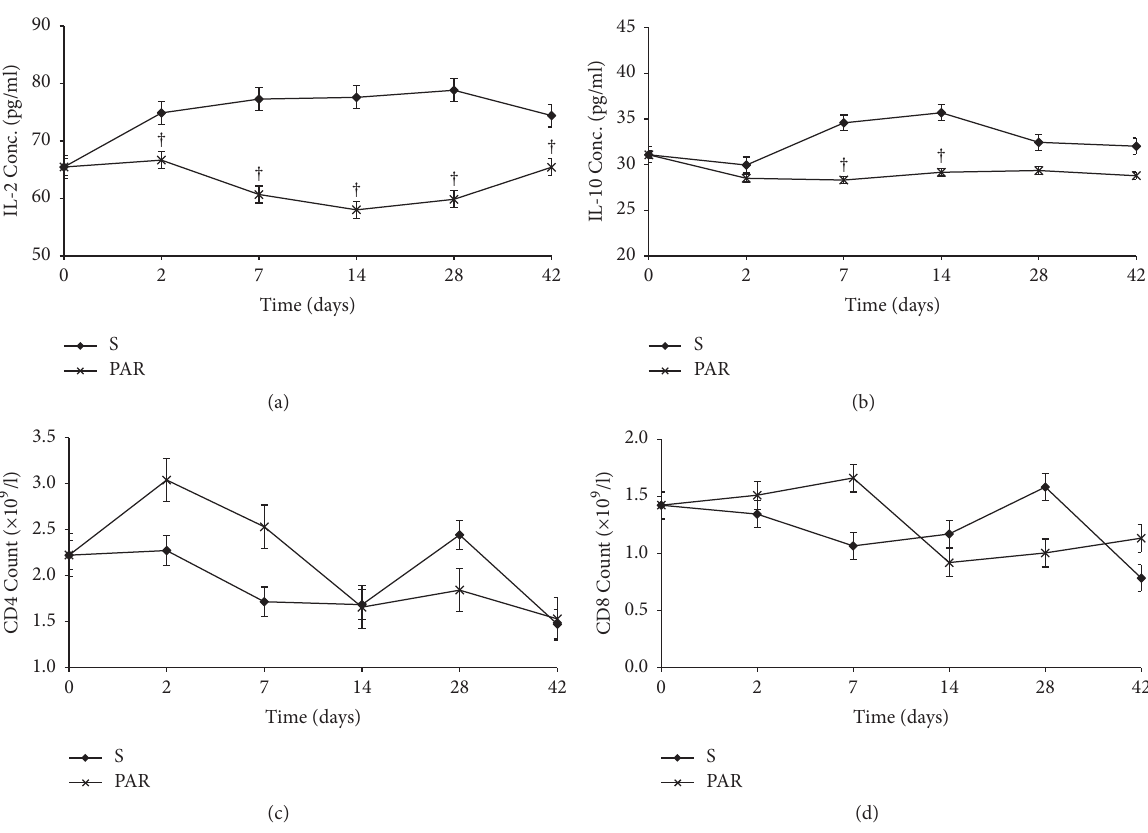
Figure 8: Serum concentrations (mean ± sd) of IL-2 (a), IL-10 (b), and CD4 (c) and CD8 (d) count during treatment with paracetamol (PAR) and saline (S). Note: † = 𝑝 ≤ 0.05